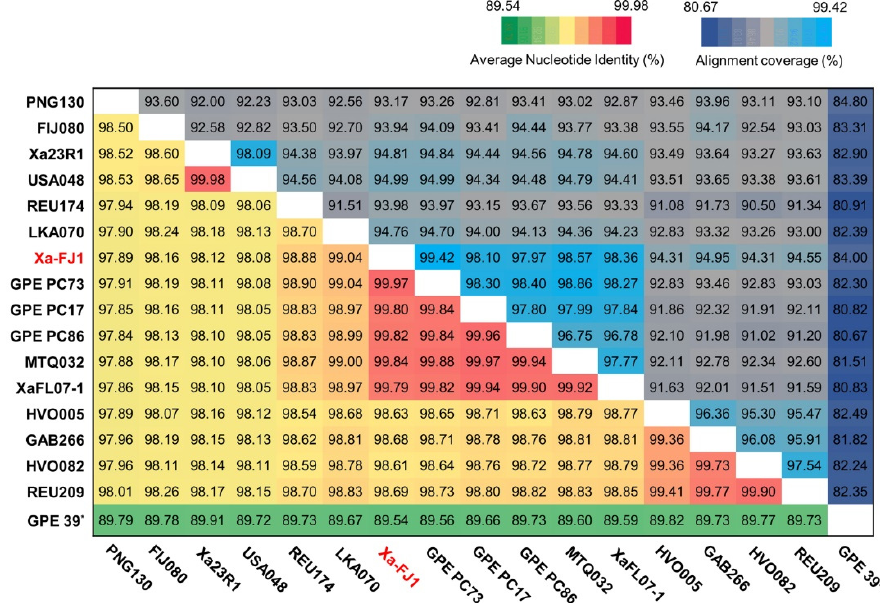
Figure 3. Neighbor-joining phylogenetic tree of X. albilineans constructed with the core-genome sequence of 16 strains of X. albilineans using TreeBesT software. Bootstrap values based on 1000 replications are indicated at branches. Scale bar units are in number of substitutions per nucleotide.